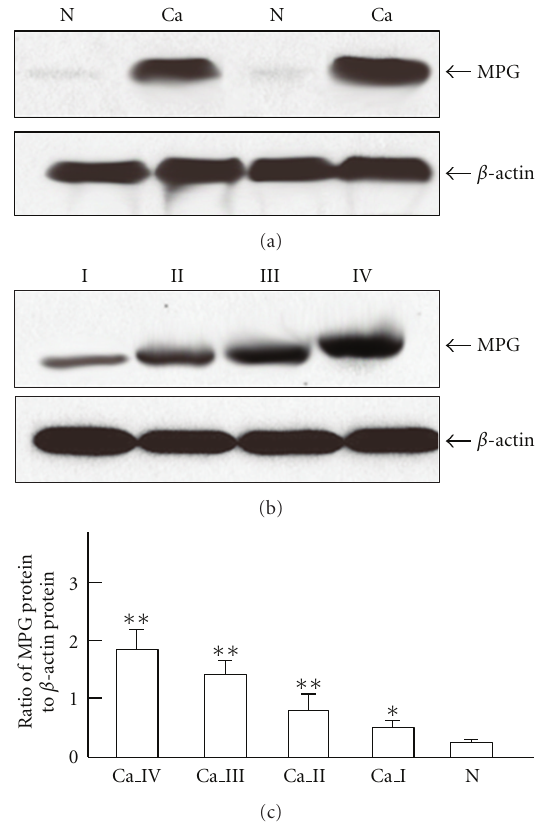
Figure 3: Expression of MPG protein in glioma and nonneoplastic brain tissues by Western blot analysis. (a) MPG protein expres- sion levels in glioma and nonneoplastic brain tissues. (b) MPG expression levels in glioma with di ff erent WHO grades. (c) MPG expression levels in nonneoplastic brain tissues and glioma with di ff erent WHO grades. “N” refers to nonneoplastic brain tissues; “Ca” refers to glioma tissues; “Ca I” ∼ “Ca IV” refer to glioma tissues with WHO grade I ∼ IV. β -actin was used as a control for equal protein loading. Values are means ± SD. ∗ P < 0 . 05, comparison with nonneoplastic brain tissues; ∗∗ P < 0 . 001, comparison with nonneoplastic brain tissues.